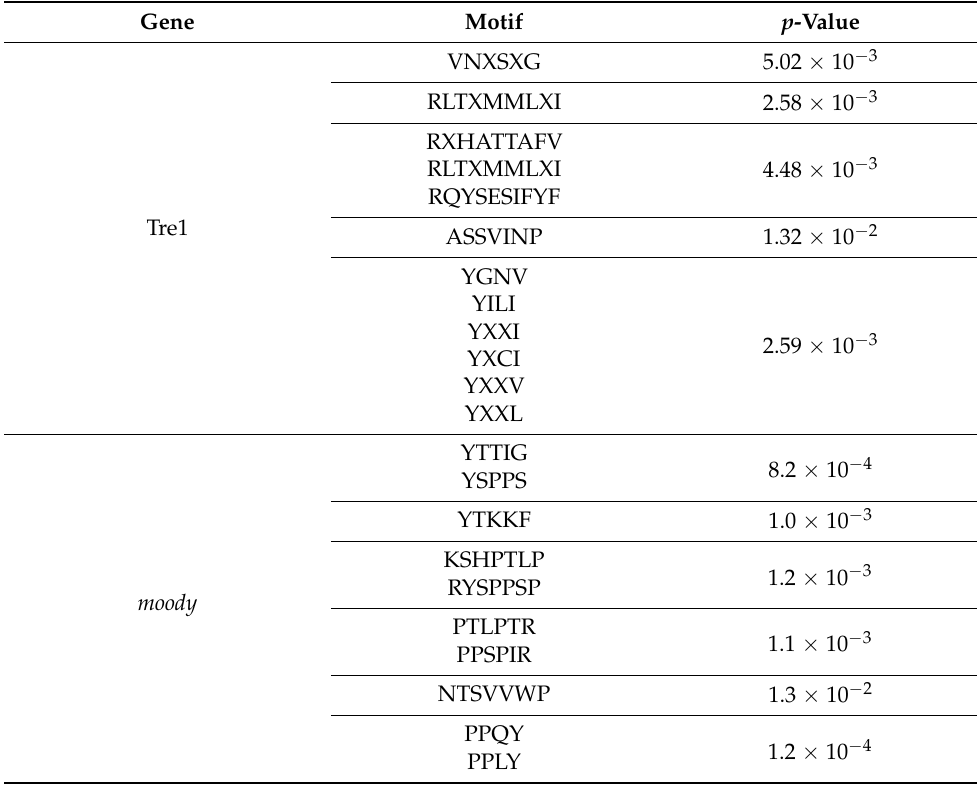
Figure 3. Tre1 in transmembrane structure. Tre1 in Drosophila possesses seven transmembrane regions common in GPCRs. Table 2. Motif shared by Tre1 family.